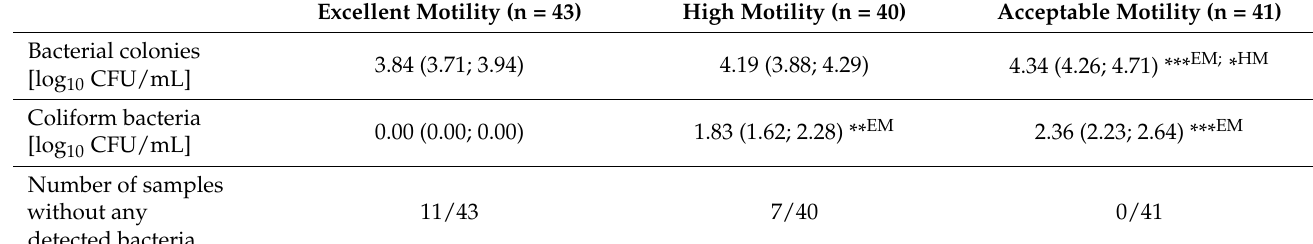
Table 5. Bacteriological characterization of semen collected from the pre-established